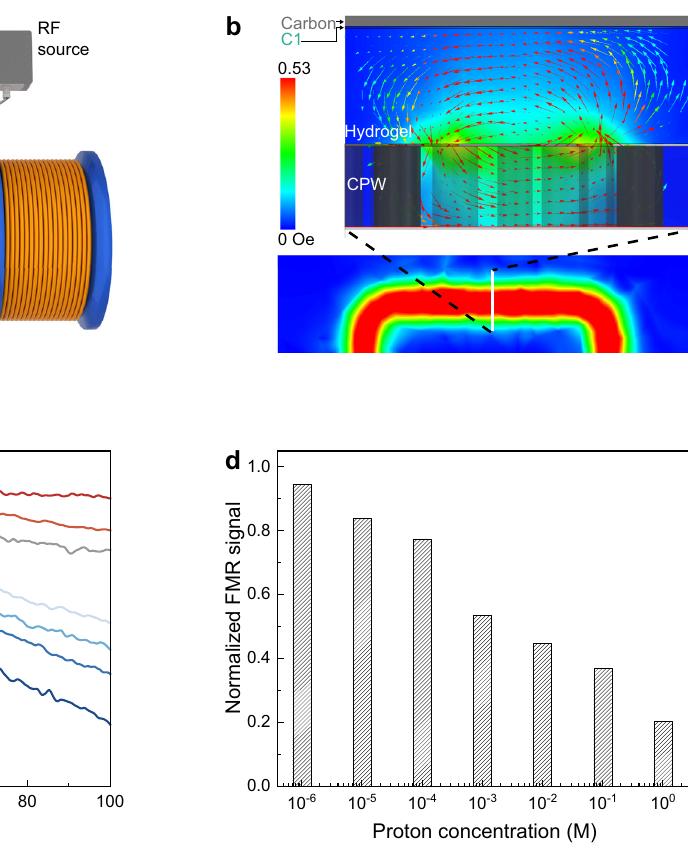
Fig.4|Magneto-ionicbasedprotonsensing.a Protonsensingsetup. b Simulation results for the magnetic fi eld distribution from the RF fi eld in the proton sensing device (Supplementary Movie 2). c Time-dependent normalized FMR signal under